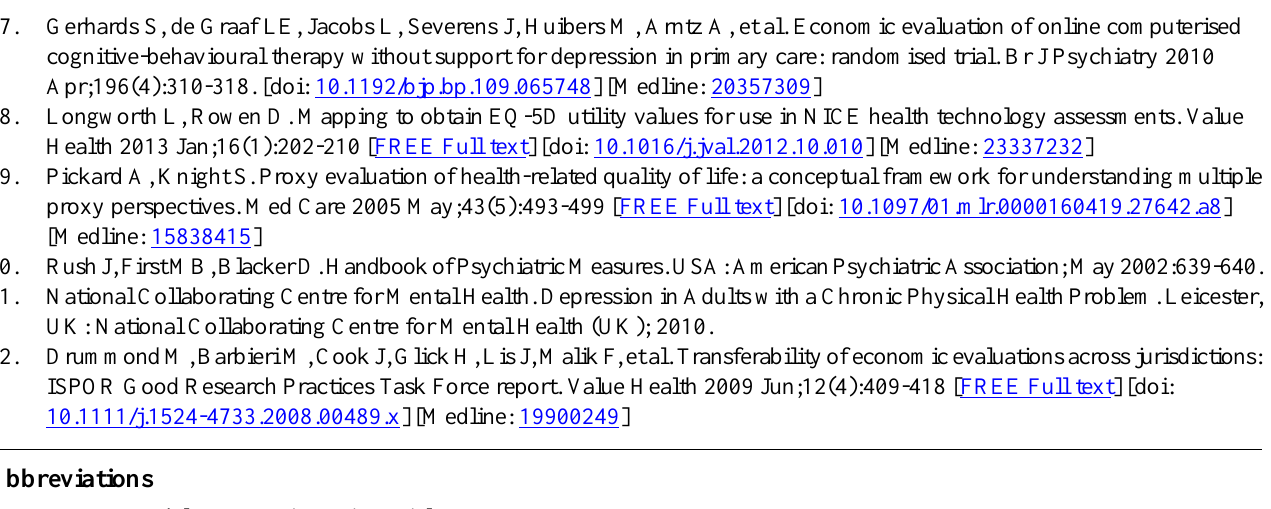
EQ-5D: EuroQoL 5-dimension questionnaire Healthy